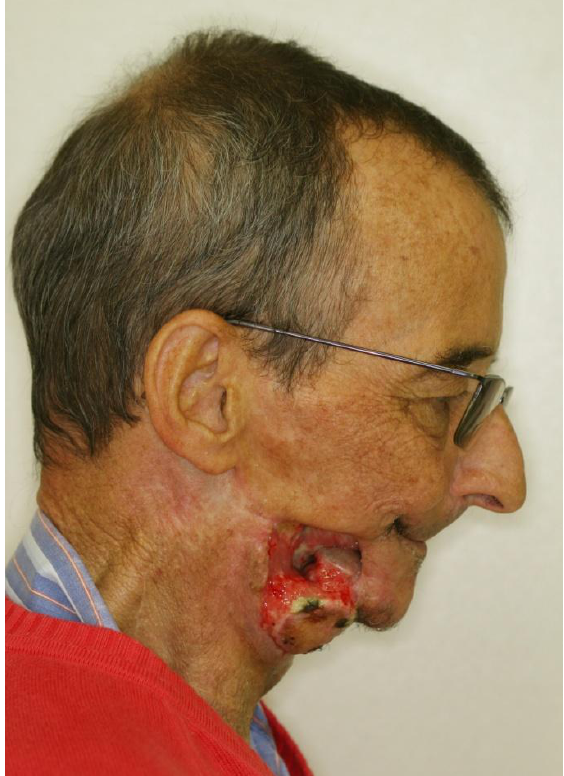
Figure 3. Severe irradiation-induced osteomyelitis with destruction of the lower jaw and the surrounding soft